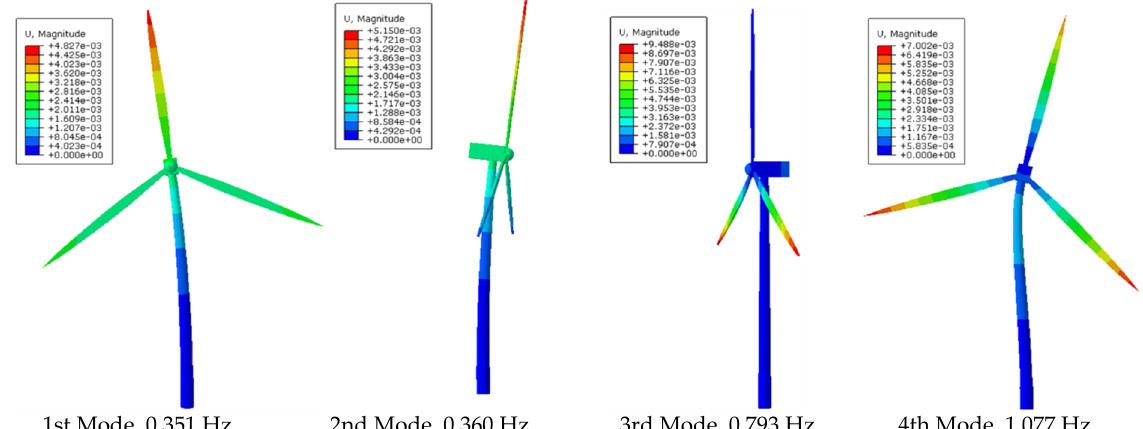
Figure 7. Model shapes of the tower.